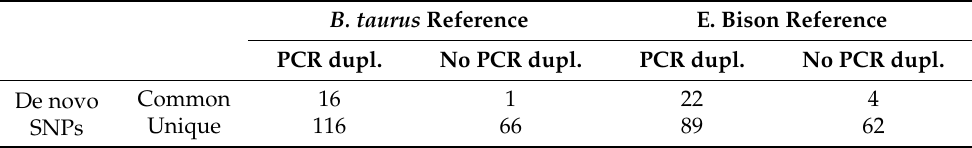
Table 4. Common and unique SNPs achieved using two different approaches: de novo and ref- erence pipeline (using Bos taurus and European bison as a reference genome), with and without PCR